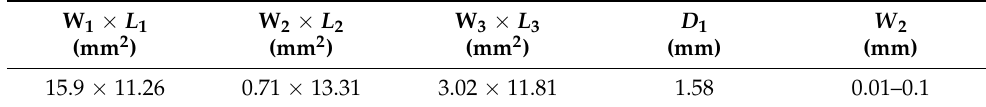
Table 1. Dimensions of the initial structure antenna.